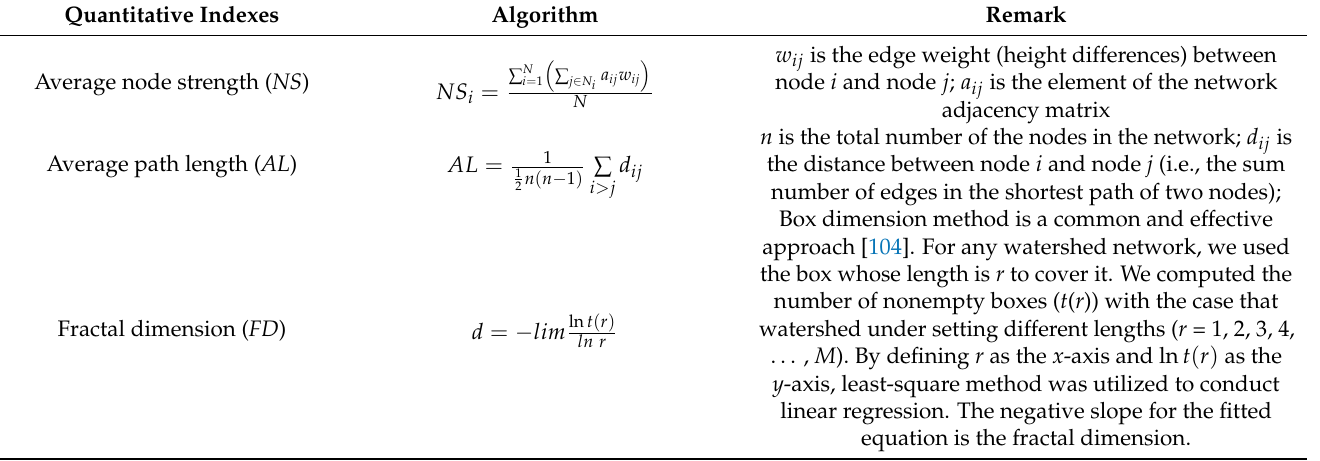
Table 2. The quantitative indexes of WWCN spatial structure and their corresponding